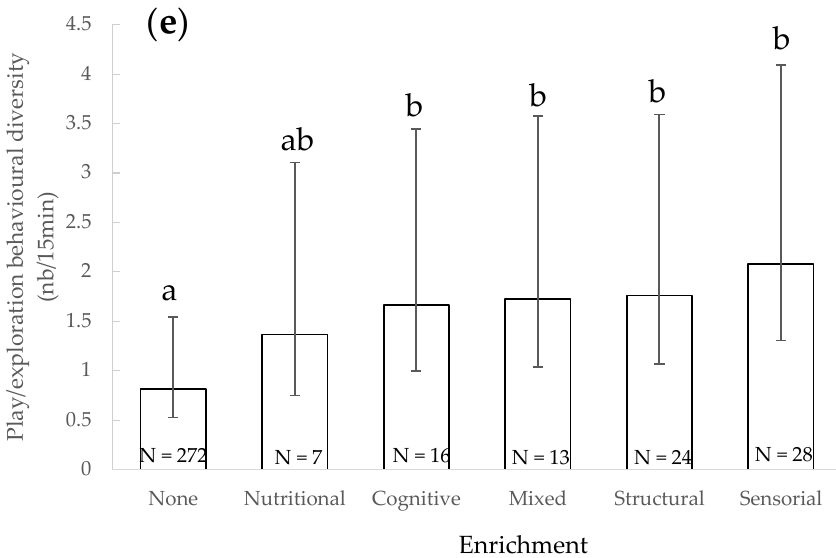
Figure 5. Mean of the play/exploratory behavioural diversity and 95% confidence intervals according to the observation location ( a ), sex of the individuals ( b ), age of the individuals ( c ), presence of visitors ( d ) and presence of enrichment ( e ). ***: p < 0.001; within each factor, categories that share the same letter do not differ significantly and categories that have no letter in common differ significantly or tend to differ (Wald chi-squared test with a sequential Bonferroni correction). N: number of observations.